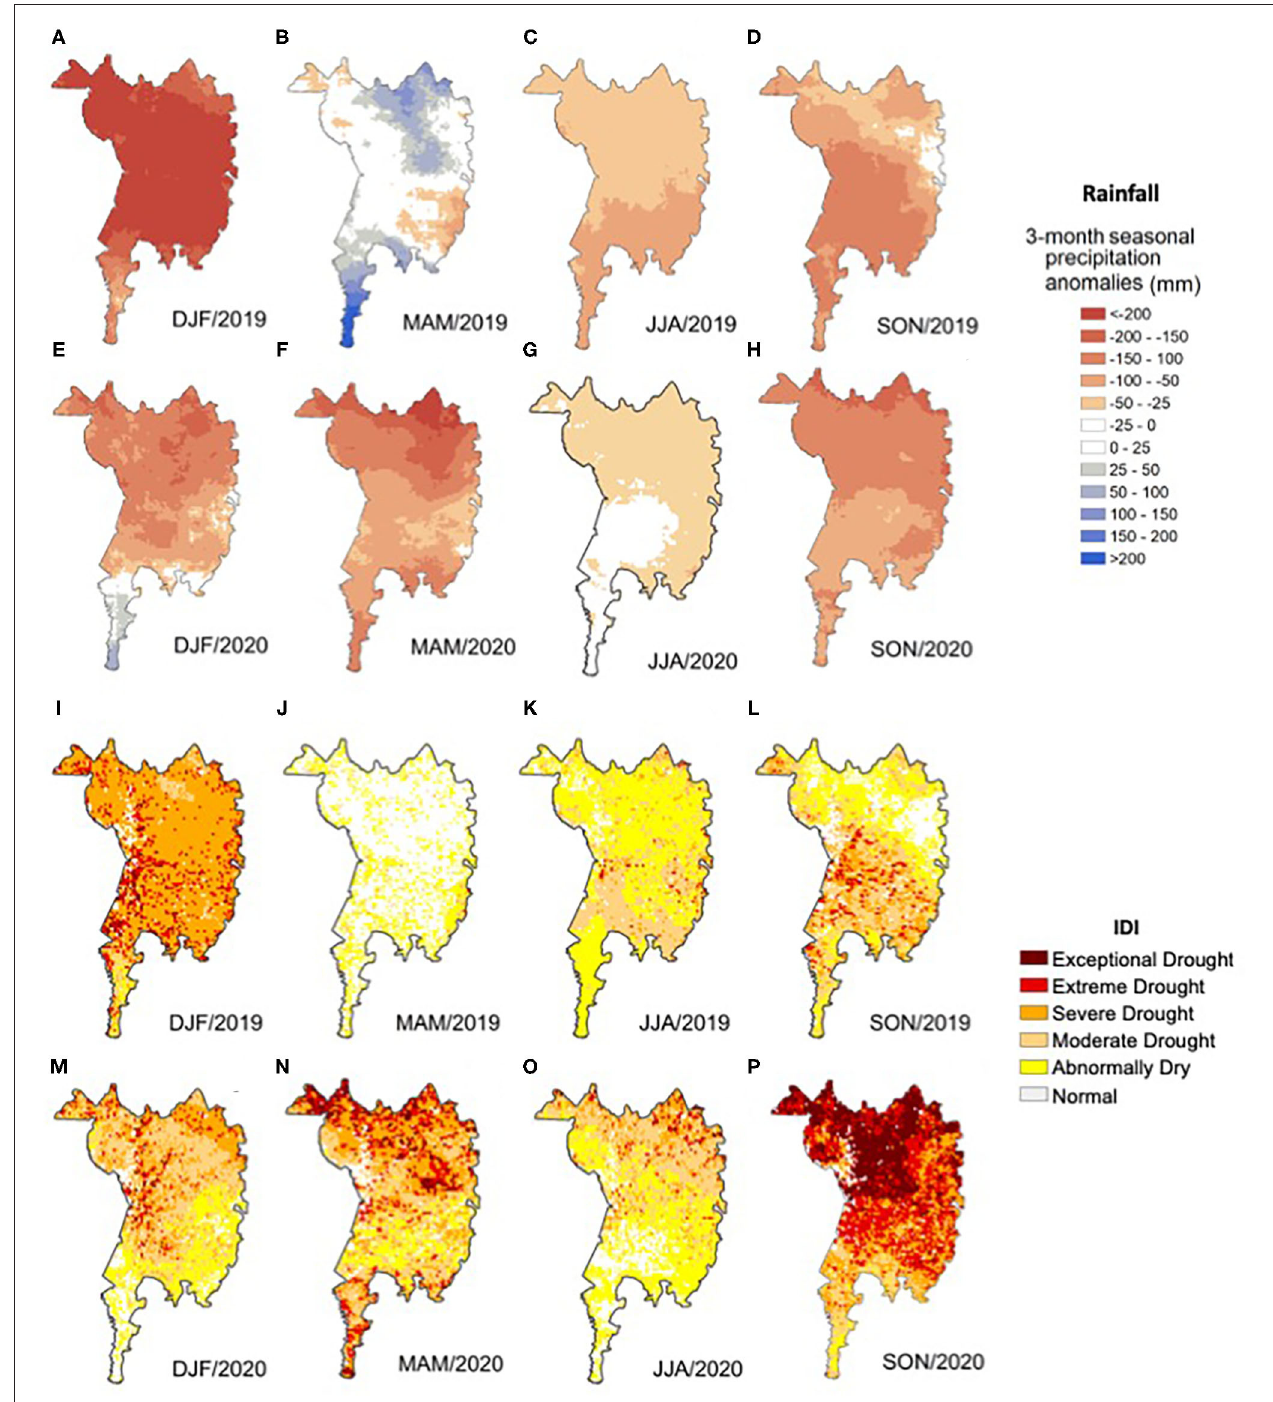
FIGURE 7 | (A–H) Seasonal rainfall anomalies for the Brazilian Pantanal from DJF 2019 to September-November 2020 in mm; (I–P) ; seasonal IDI values for the Brazilian Pantanal from December-February 2019 to September-November 2020. Base period is 1981–2010.